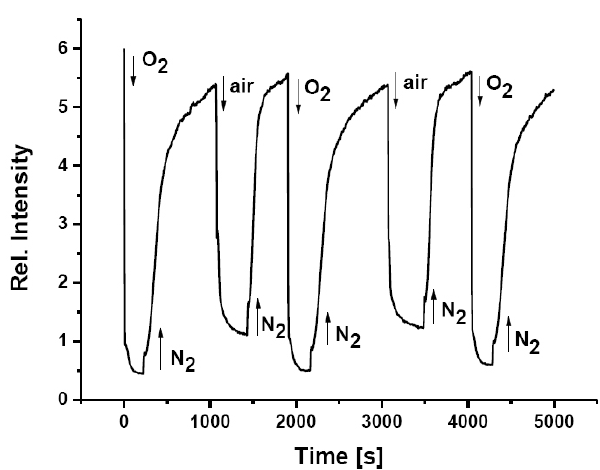
Figure 4. Gas dependent phosphorescence of CPM/PdTMPyP